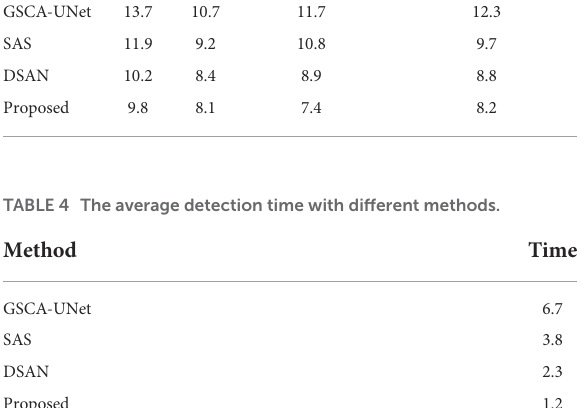
Figure 8, three groups of different training images in the source data set are shown. The three groups of images represent